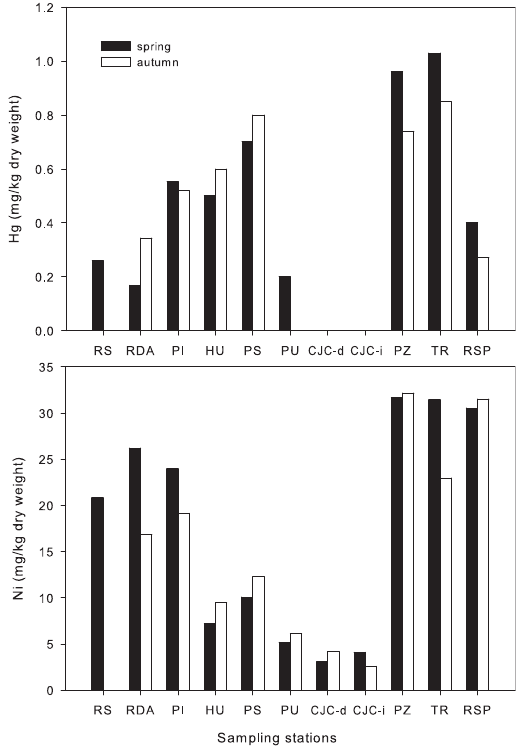
Fig . 3. – Concentrations of mercury and nickel (mg kg -1 dry sedi- ment) at the sampling stations for spring and